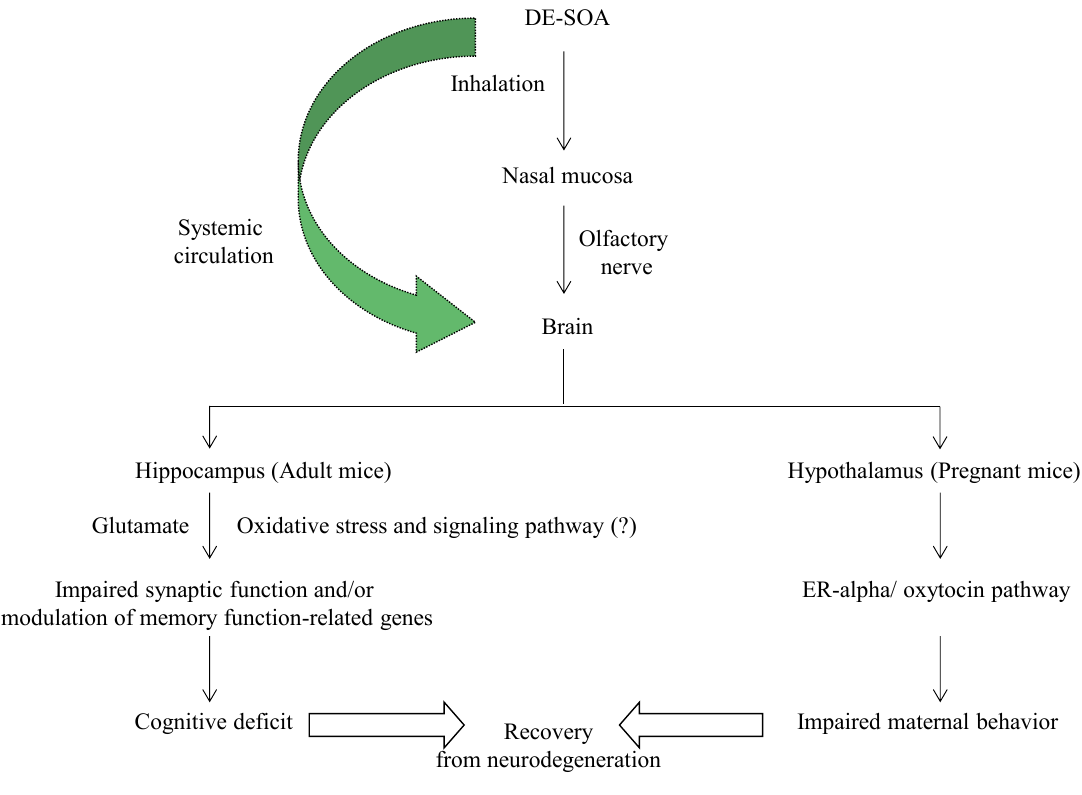
Figure 5. Hypothetical pathway of DE-SOA induced